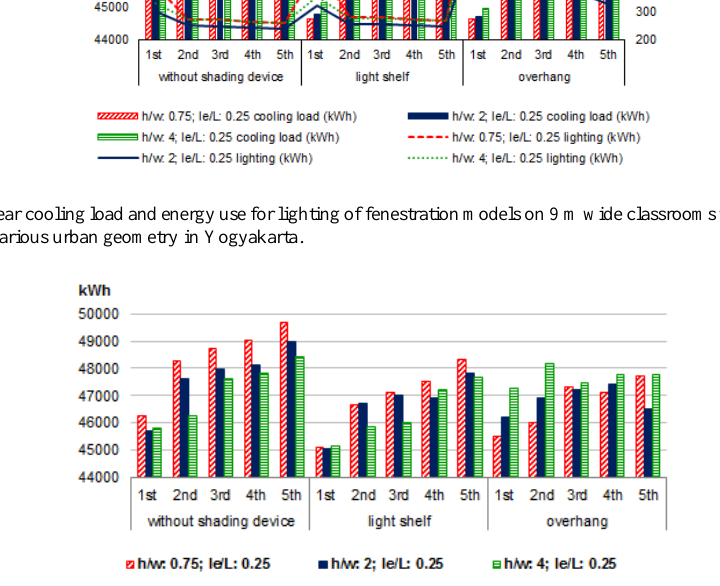
Fig. 10. One-year total cooling load and energy use for lighting of fenestration models on 9 m wide classrooms with South- facing windows in various urban geometry in